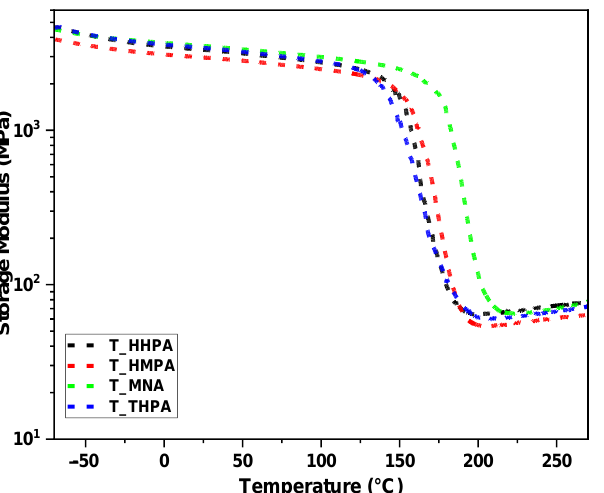
Figure 5. Storage moduli ( E’ ) in function of temperature of designed T-anhydride thermosets.